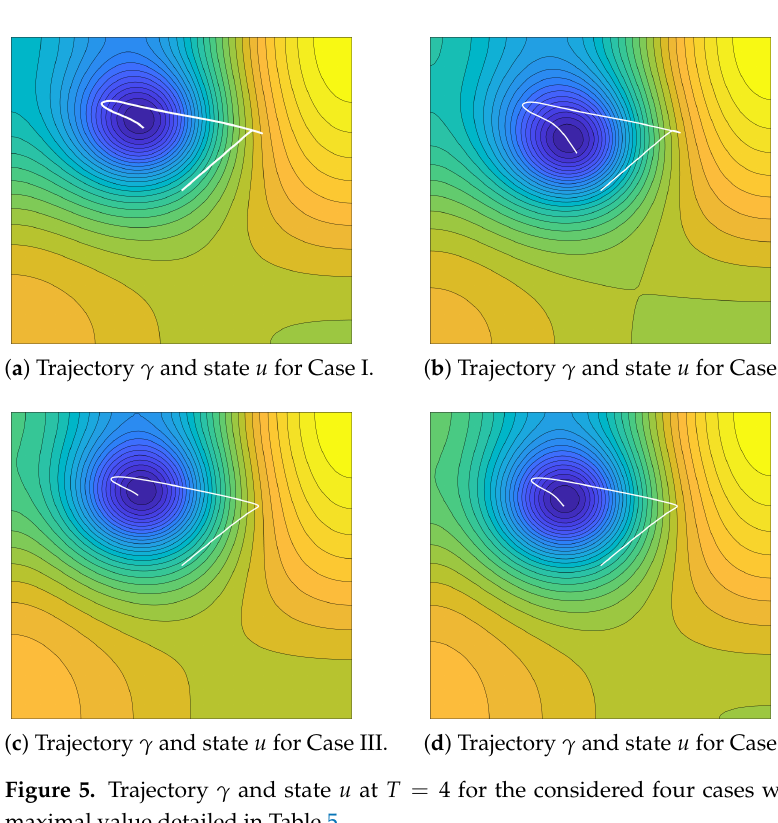
Figure 4. Trajectory γ and state u at T = 2 for the considered four cases with a minimal and a maximal value detailed in Table 5.